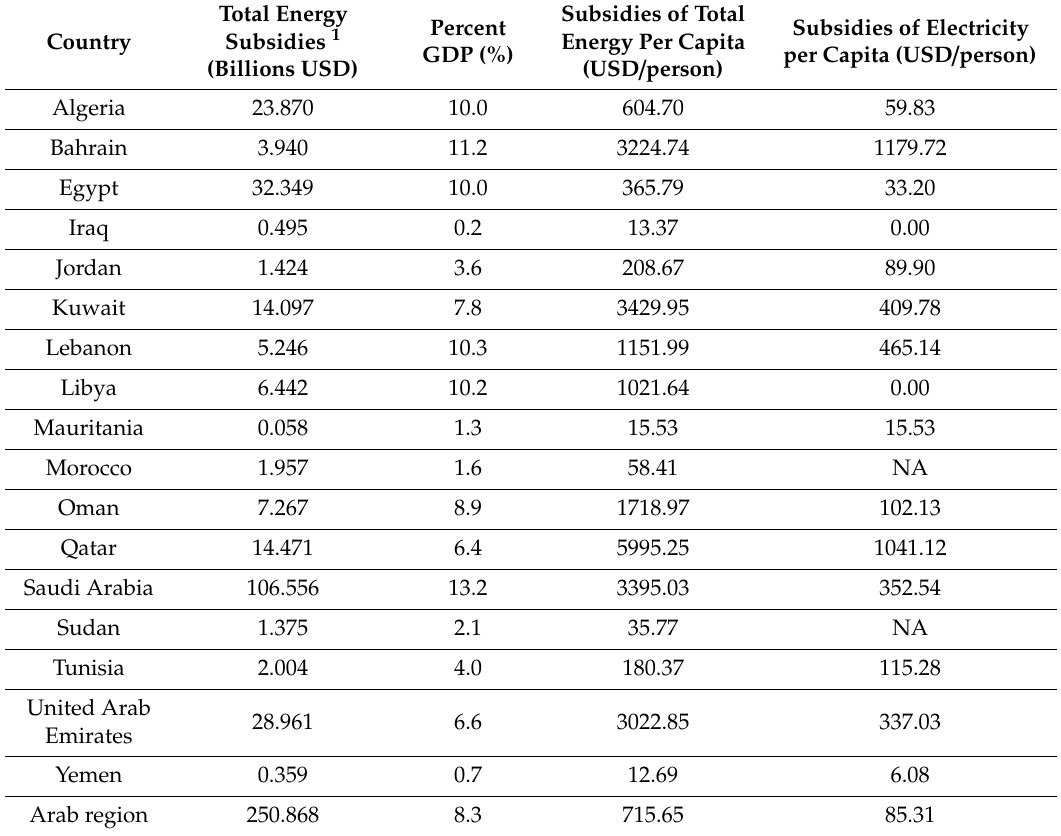
Table 7. Energy subsidies in the Arab region (Source, International Monetary Fund (IMF)